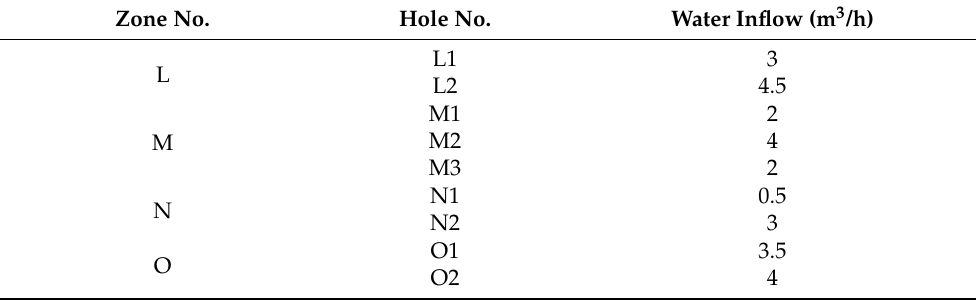
Table 1. Water inflow statistics of the drilling test. Zone No. Hole No. Water Inflow (m 3 /h) L